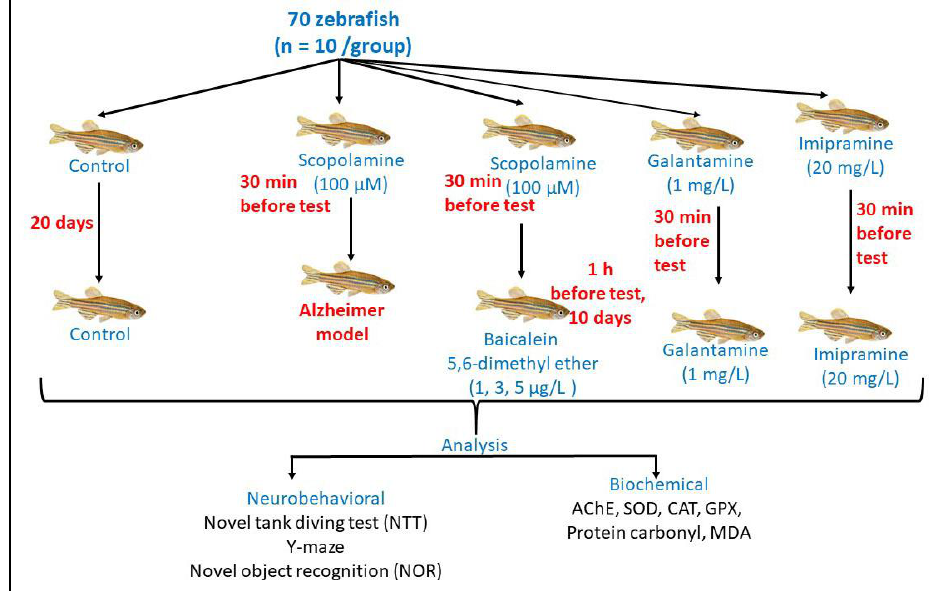
Figure 7. Schematic representation of the study experimental design, behavioral tests, and biochemical analyses.